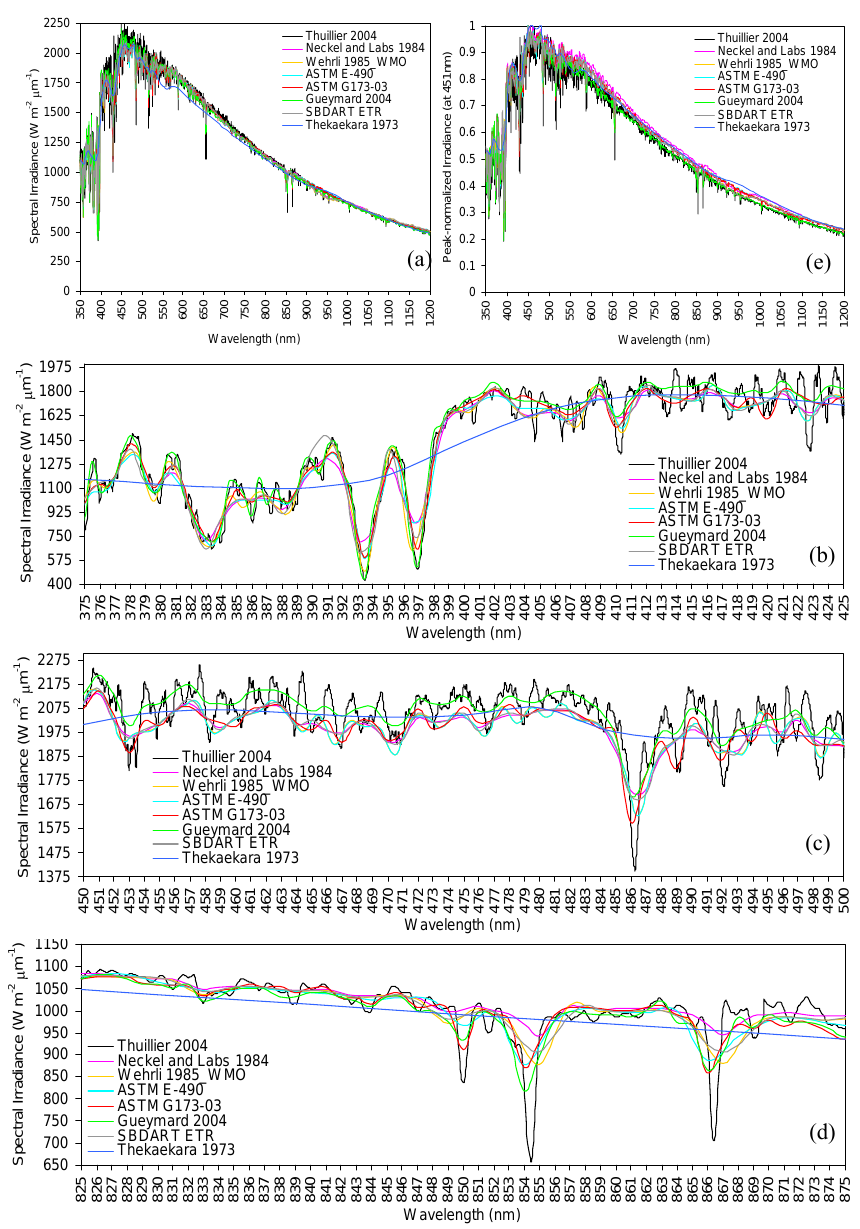
Fig. 3. (a) The spectral irradiance of the eight reference spectra in the UV to NIR (from 350–1200nm) domains, (b–d) their magnified portions in the ultraviolet-blue-green and NIR, and (e) the peak-normalized irradiance values (at 451nm) in the 350–1200nm